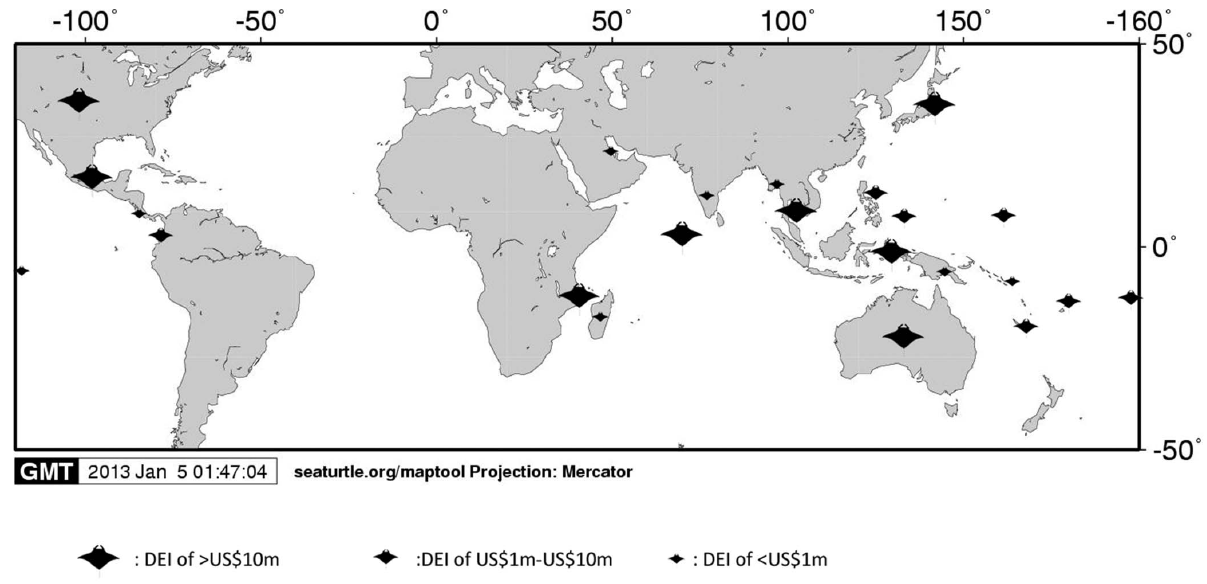
Figure 1. Global distribution and direct economic impact (DEI) of manta watching tourism. Direct economic impact comprises estimated tourist expenditures on manta ray dives and associated expenditures, such as lodging, food and local transportation, which can be attributed to manta ray diving.